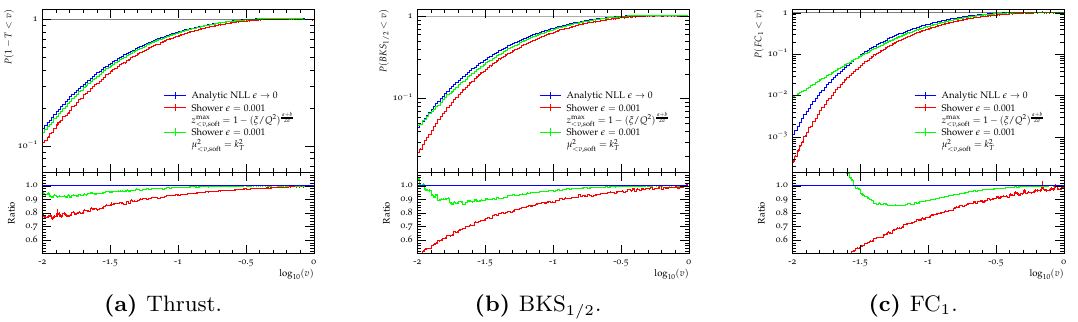
Figure 3 . E(cid:11)ect of replacing the constraint z < 1 sectorization constraint, (cid:17) > 0 and e(cid:11)ects arising from the evaluation of the strong coupling at k 2 with k min = 0 : 5 GeV. T